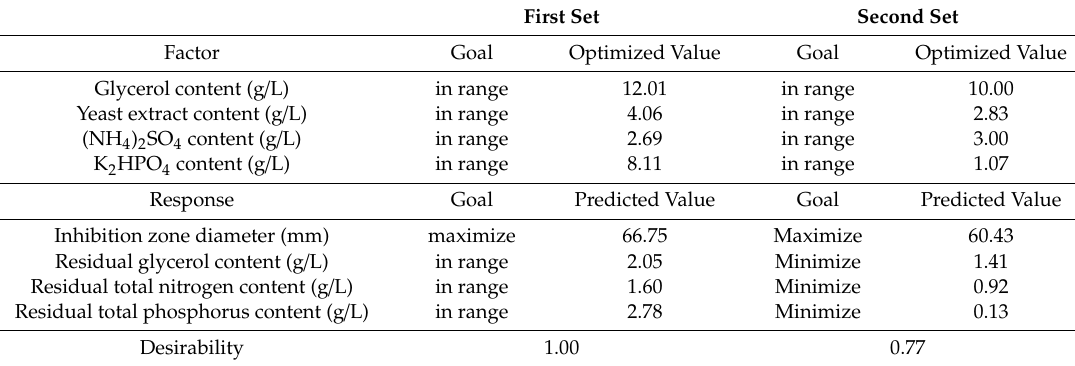
Table 3. Results of the optimization of medium composition for cultivation of B. velezensis